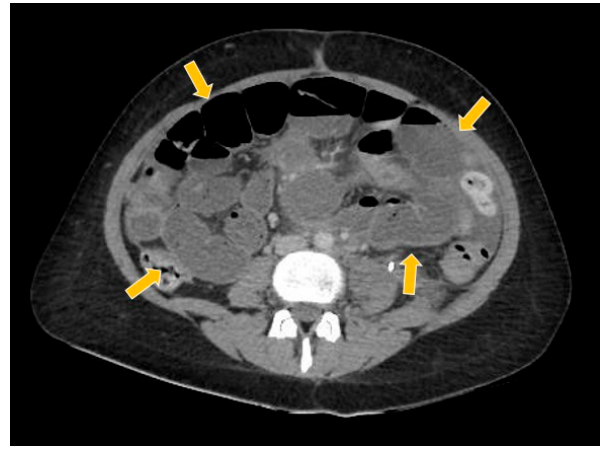
Figure 10. The computed tomography study in the portal phase showing the dilation of slender loops (yellow arrows) by distal extrinsic compression (new pelvic lesion).